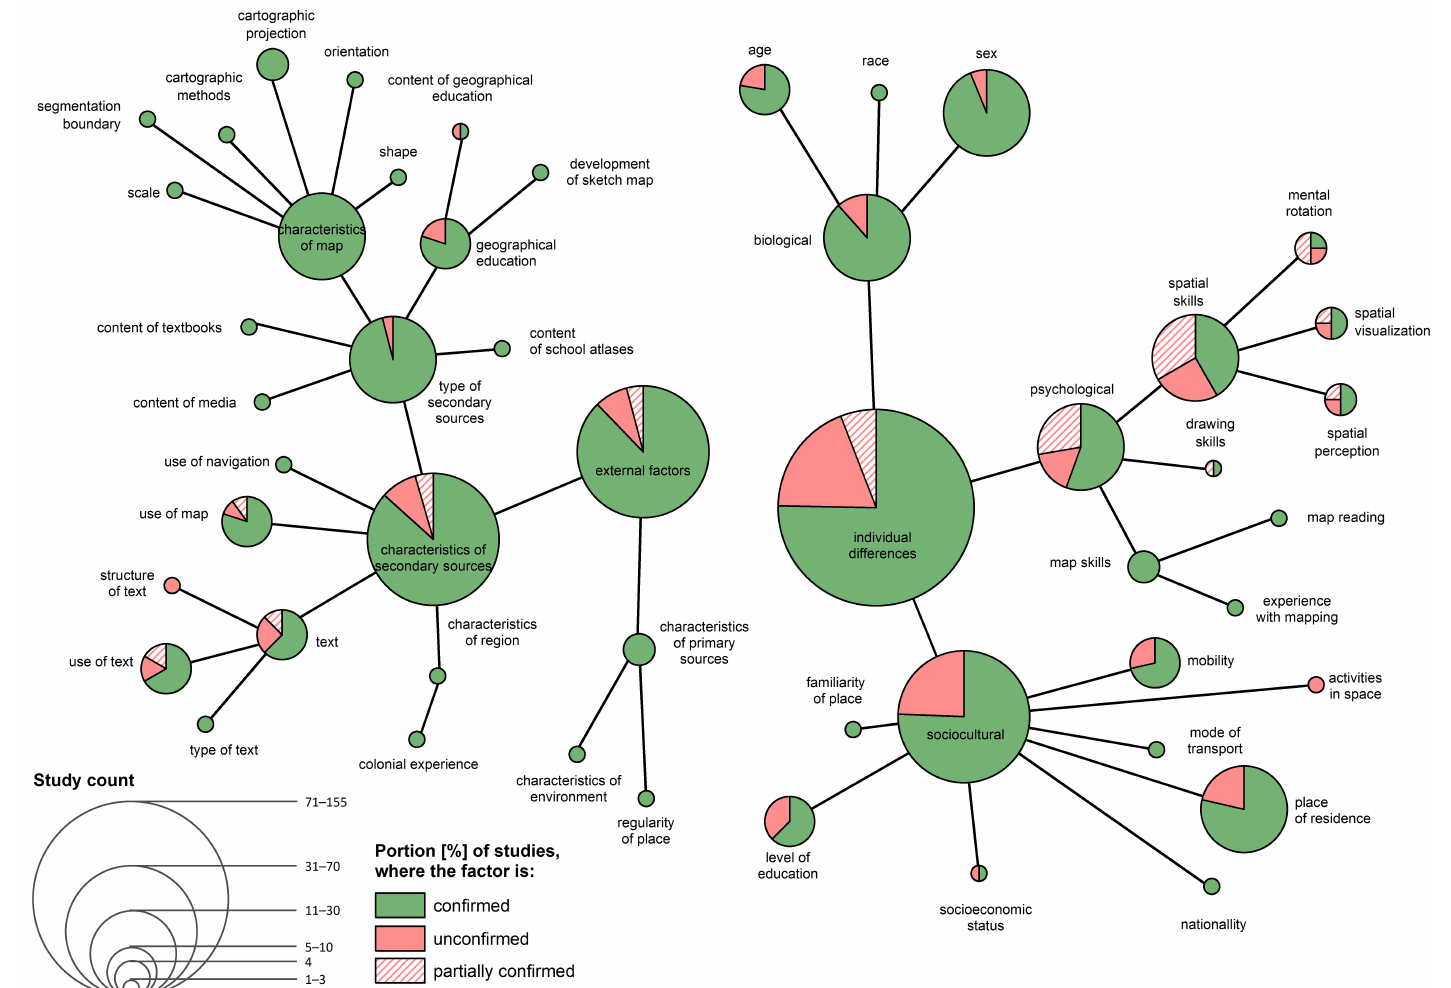
Figure 7. Factors influencing positional accuracy in sketch